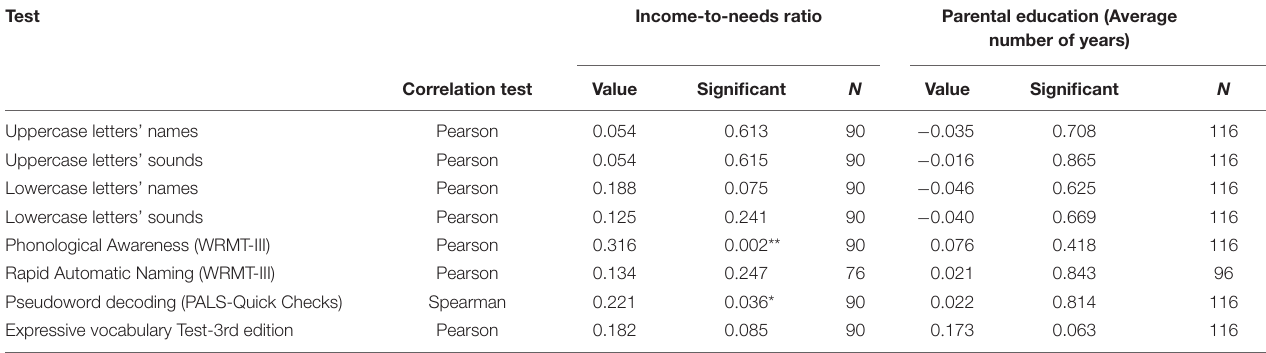
TABLE 5 | Correlation between SES measures and the baseline performances across